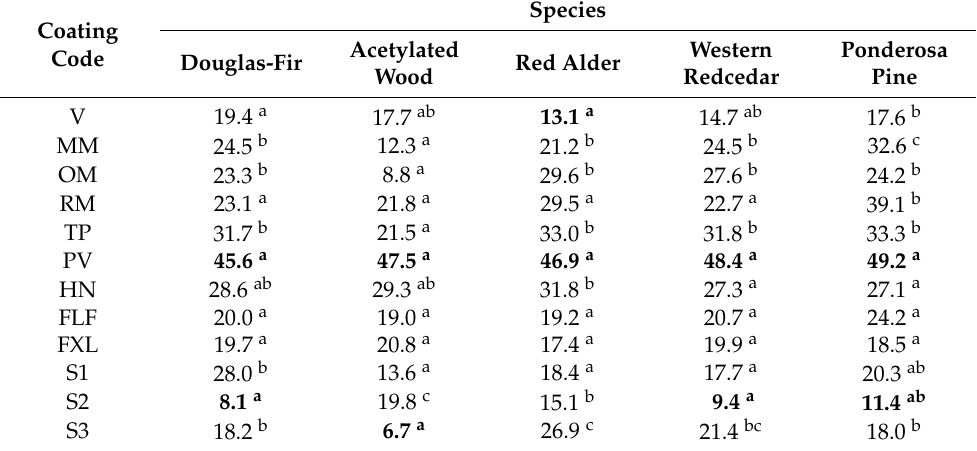
Table 2. Games–Howell pairwise mean differences of color change within coatings at 18 months of the study. Letters in superscripts indicate means between treatment groups (species) that are not significantly different at the p < 0.05 level. The highest and lowest values for each species are shown in bold.